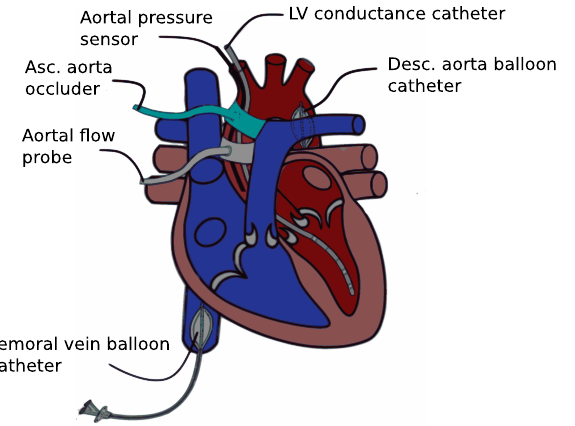
Figure 1. Scheme of the instrumentation of the heart with a conductance catheter, flow and pressure sensors and an inflatable occluder around the ascending aorta and femoral and aortal balloon catheters. (Ao.: aortic, asc.: ascending, desc.: descending, fem.: femoral, LV: left ventricle. Figure is a modification of figure “Heart normal” by Eric Pierce 57 . The original figure can freely be published under CC BY-SA license (https ://en.wikip edia.org/wiki/User:Wapca plet).